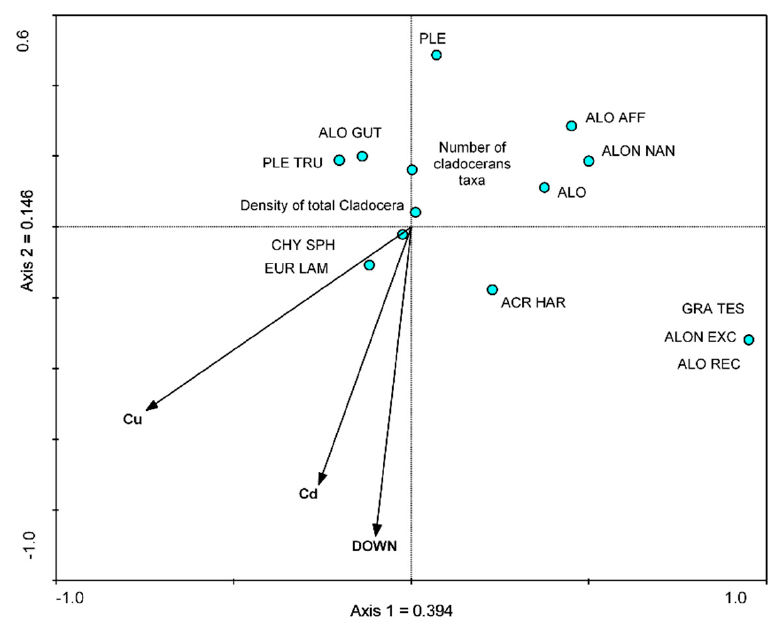
Figure 7. Canonical correspondence analysis (CCA) diagram for selected Cladocera species. The biplot illustrates the relationship between the heavy metal concentration in the sediment cores and Cladocera fauna. Taxa name code see Figure